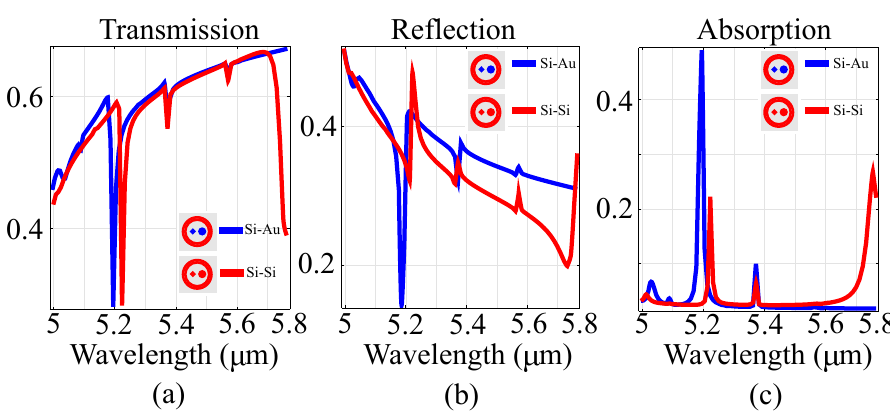
Figure 3. ( a ) transmission, ( b ) reflection and ( c ) absorption of the all-silicon and gold-silicon metasur- face cells in the spectral regions of interest. The inset presents the layout of the cell in the xy plane. The red color in the inset indicates silicon, while the blue color indicates